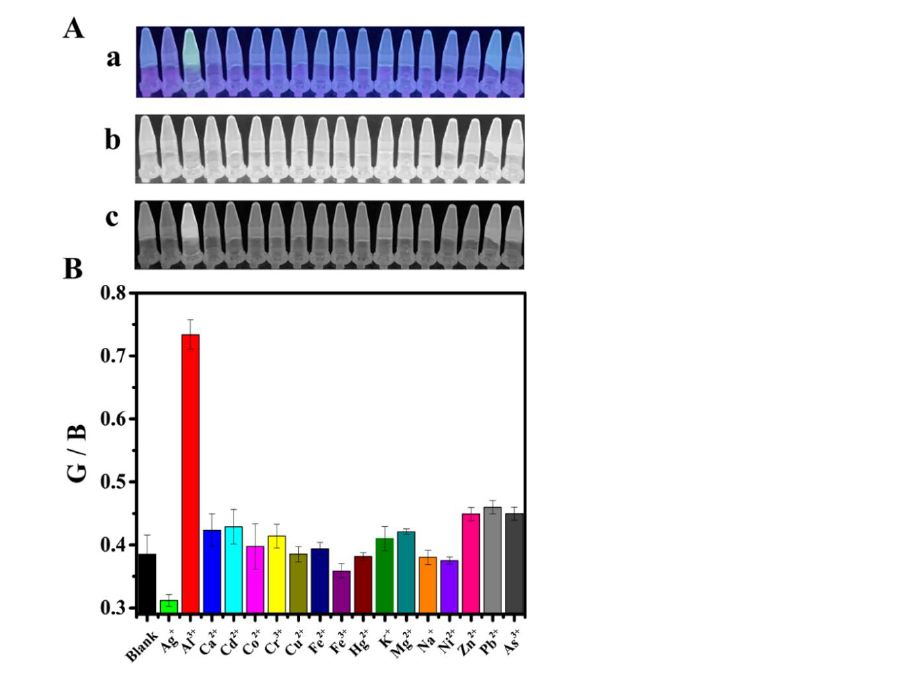
Figure 6. ( a ) Images of the CDs-ions solution obtained with a smartphone under a 360 nm UV lamp. ( b ) Blue channel and ( c ) green channel content of the image ( A ). ( B ) G/B value responses depending on the nature of the metal ions; the concentration of the metal ions measures 307.69 μM.